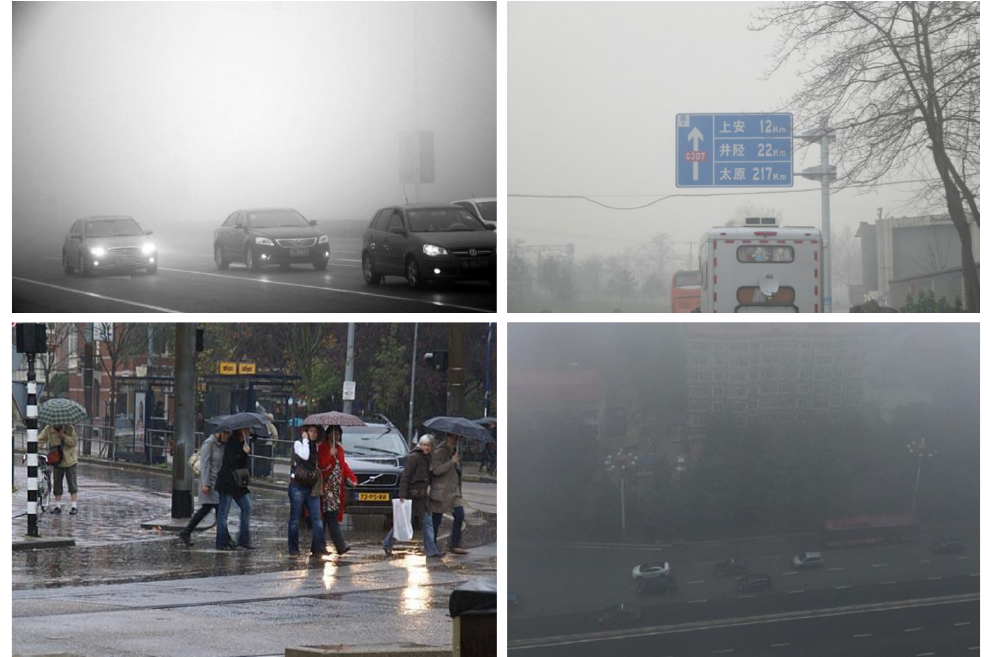
Figure 6. Dataset sample taken from RESIDE dataset. This dataset contains images of vehicles, roads, traffic signs, and signboards explaining directions captured in harsh weather